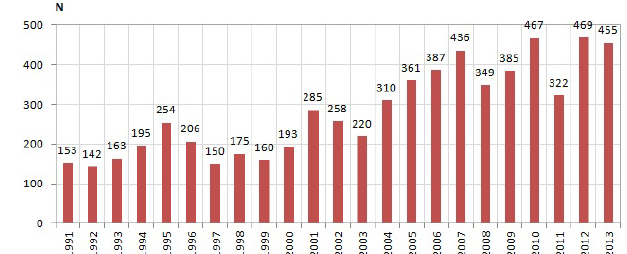
Figure 2. Number of dangerous hydrometeorological phenomena